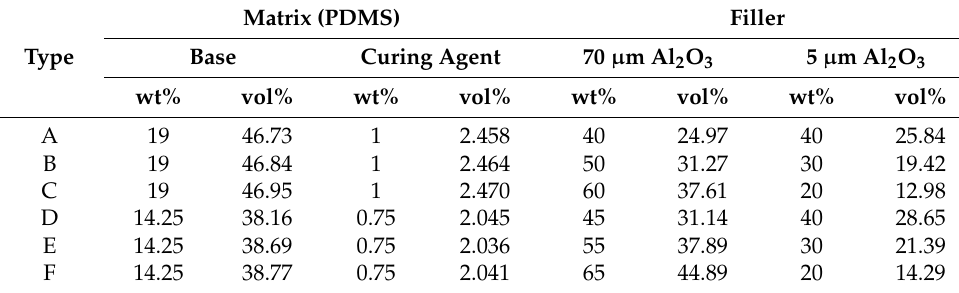
Table 2. Mixing ratio using aluminum oxide powder with different